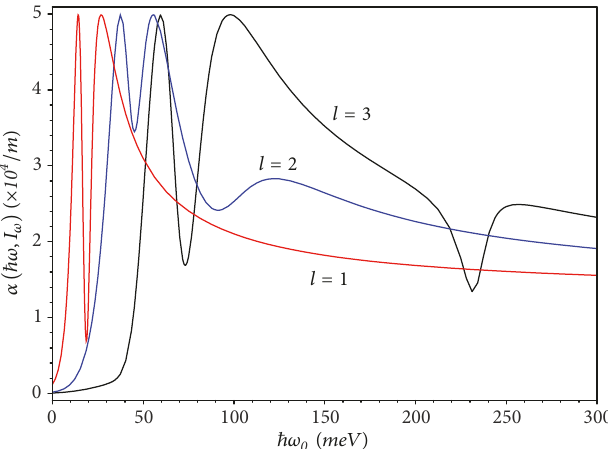
Figure 4: Dependence of AC (involving the ground state) on the inverse parabolic potential for three first three radial quantum numbers. The incident radiation has energy ℎ𝜔 = 20 meV and radius of the quantum wire is 𝑅 = 100